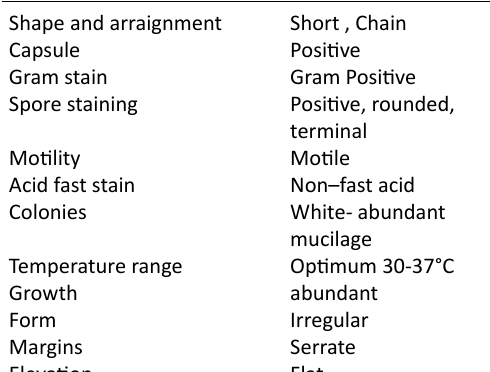
Table 2. Physiological and biochemical characteristics of Bacillus